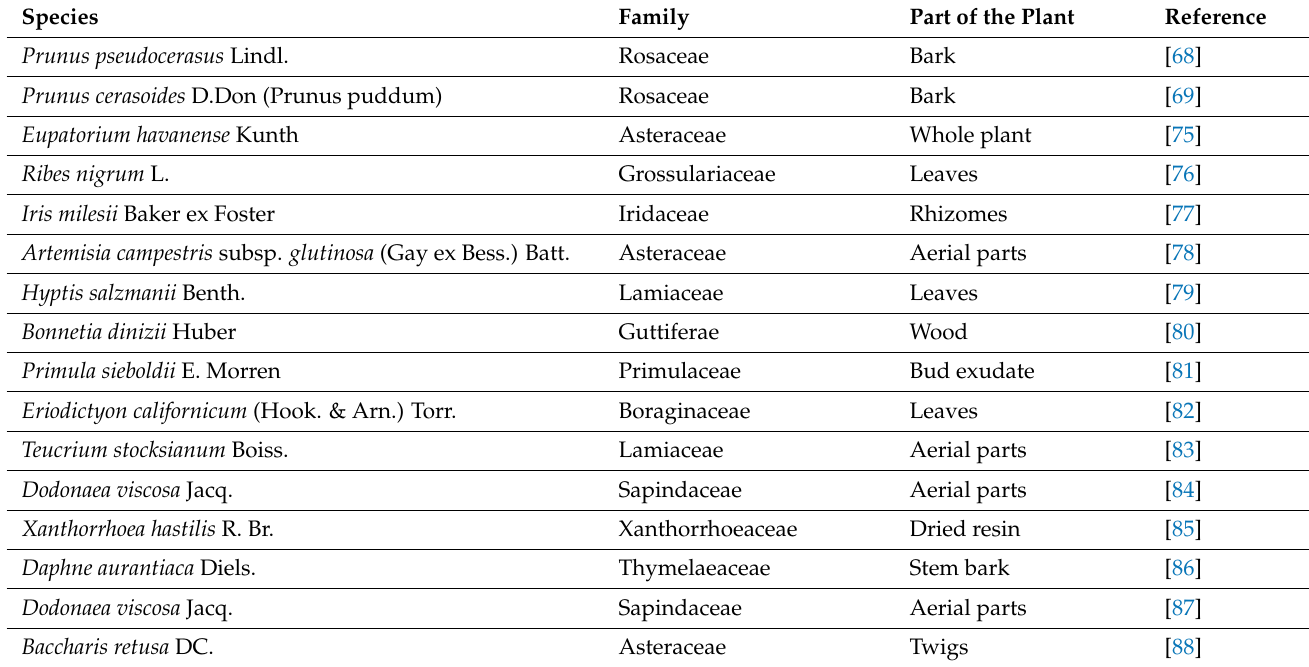
Table 2. Plant species in which sakuranetin has been identified in recent